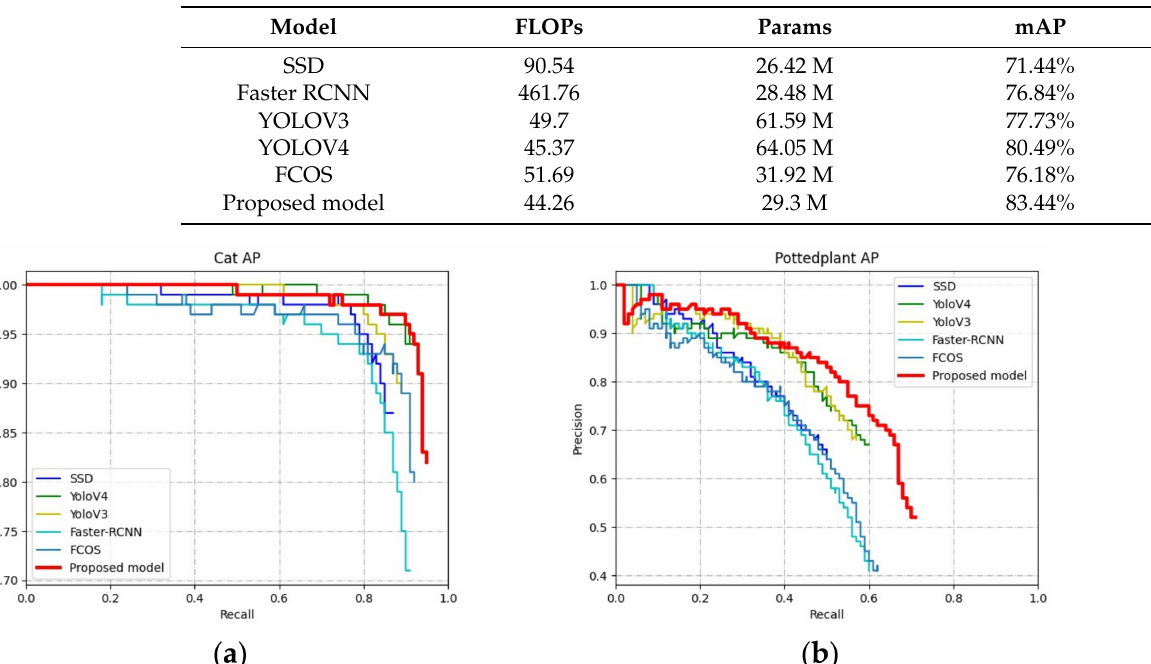
Figure 9. P–R curves for two categories from the PASCAL VOC2007 test set: ( a ) Cat; ( b )